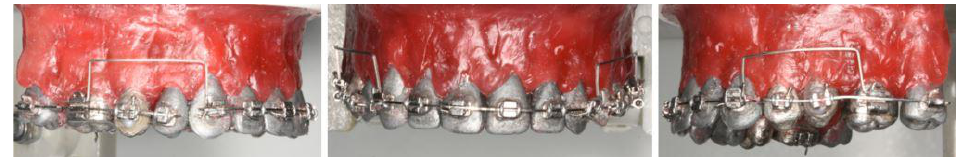
Figure 1. Symmetric activation of 10 mm UA (typodont).